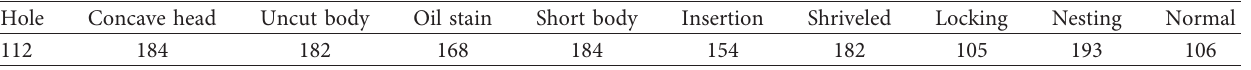
Table 1: Specific quantity of each capsule.